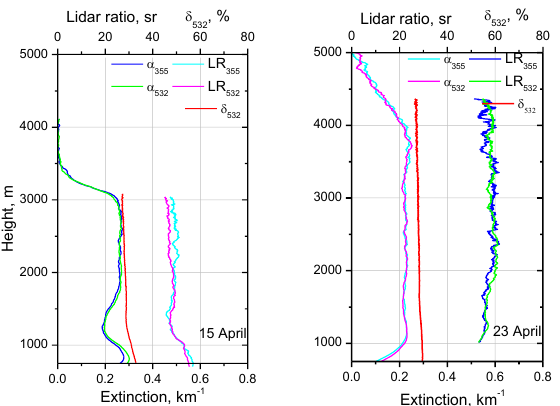
Figure 5. Vertical profiles of extinction coefficients and lidar ratios at 355 and 532 nm together with  532 for the nights 15-16 and 23-24 April 2015.